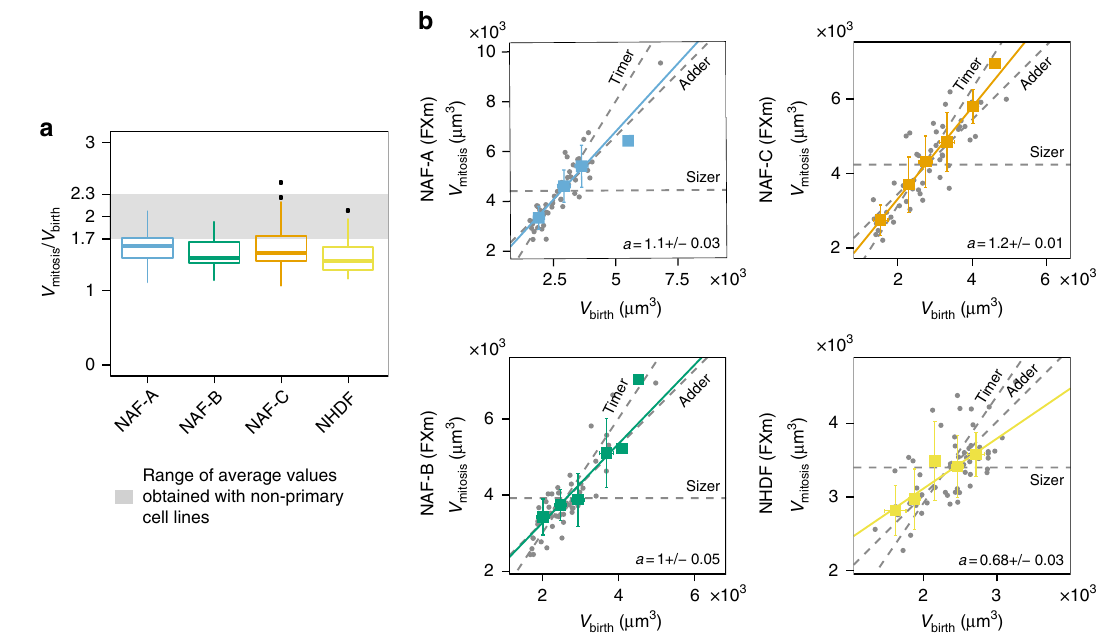
Fig. 3 Near-adder behavior in primary human cells. a Boxplot showing the distribution of over replicative growth (volume at mitosis divided by volume at birth) for three samples of NAF and NHDF primary cells. NAF-A:, n = 48, N = 2; NAF-B: n = 53, N = 2; NAF-C: n = 53, N = 2; NHDF: n = 56, N = 3. b Volume at mitosis as a function of volume at birth for three samples of NAF and NHDF primary cells. Dashed lines are visual guides for the timer timer (assuming exponential growth, slope = 〈 V mitosis / V G1/S 〉 , intercept = 0), adder (slope = 1, intercept = 〈 Δ V S − G2 〉 ) and sizer (slope = 0, intercept = 〈 V 〉 ). Solid lines represent linear fi ts on the bins (colored squares) weighted by the number of observations in each mitosis